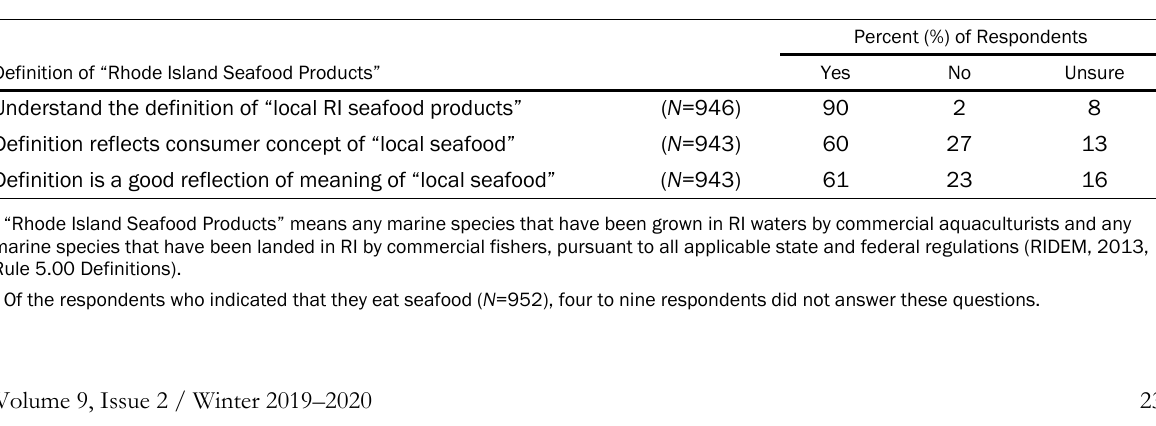
Table 8. Consumer Interpretation of the “Rhode Island Seafood Products” Branding Definition a per Legislation ( N =943–946 b